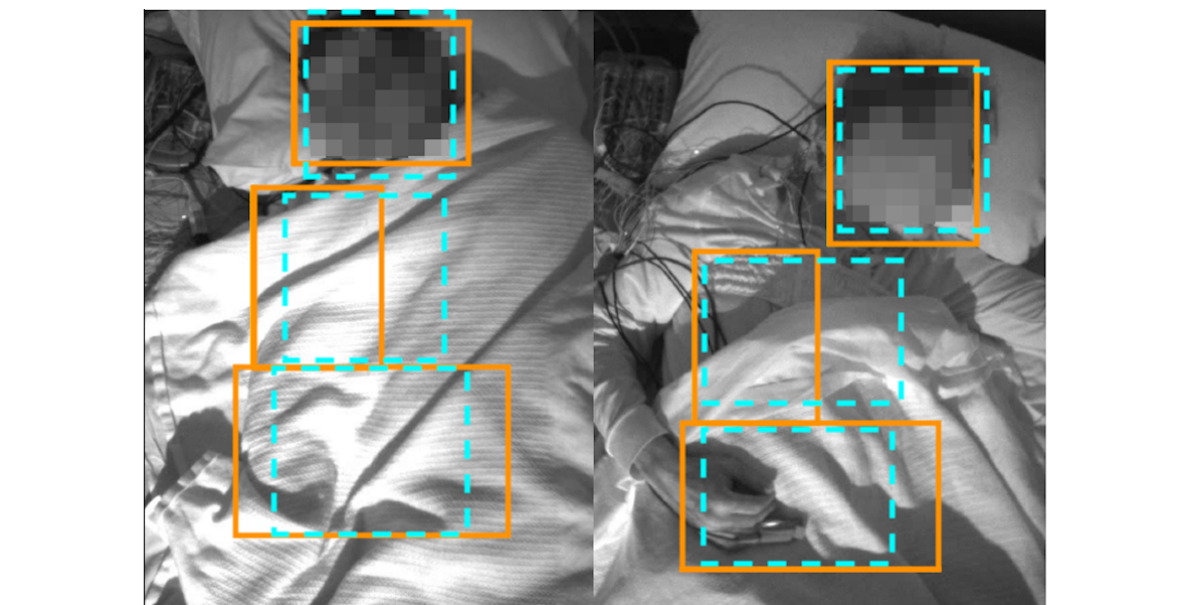
Figure 6. Sample chest, abdomen, and head detection results. Manually annotated and detected regions are shown in blue hashed line and orange solid line,